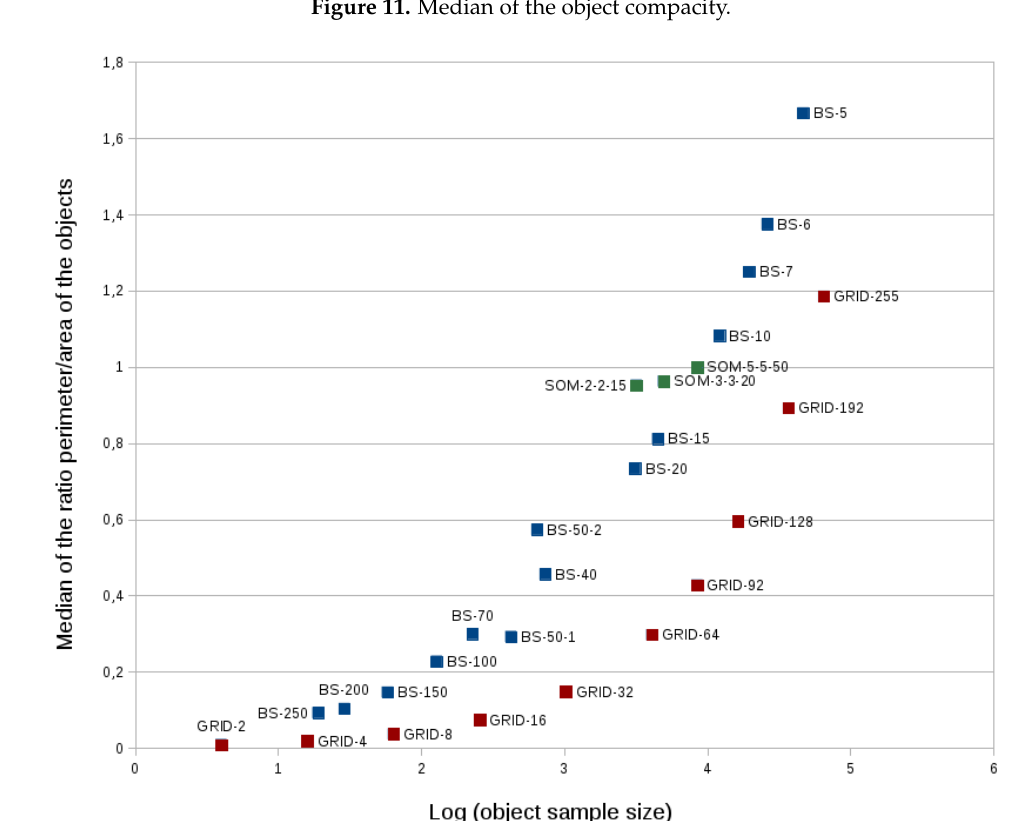
Figure 12. Ratio Perimeter/Area of